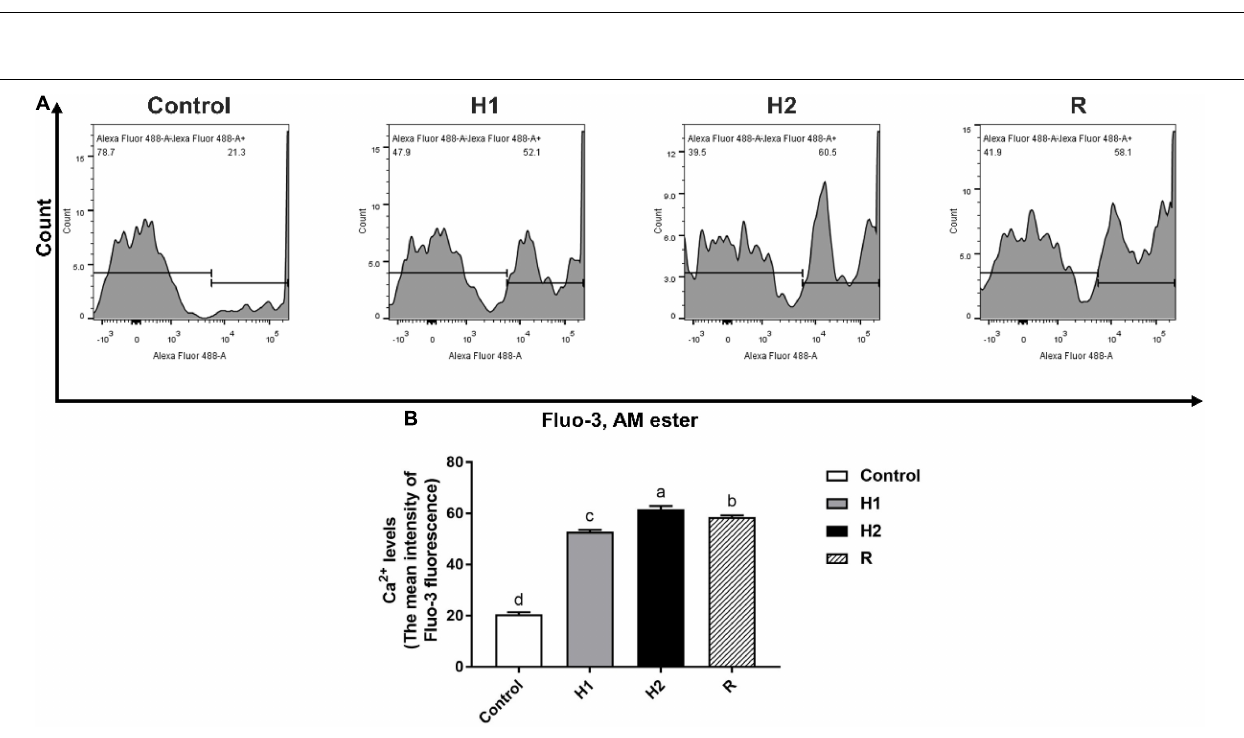
FIGURE 3 | The change of Ca 2 + levels in the blood cell of largemouth bass under acute hypoxia and reoxygenation. (A) The Ca 2 + levels of blood cell was determined by flow cytometry. (B) The Ca 2 + levels for each cell treatment. Data are expressed as the mean ± SD ( n = 3; one-way analysis of variance followed by the T -test). All experiments were conducted in triplicate. Different letters denote significant differences ( P < 0.05).